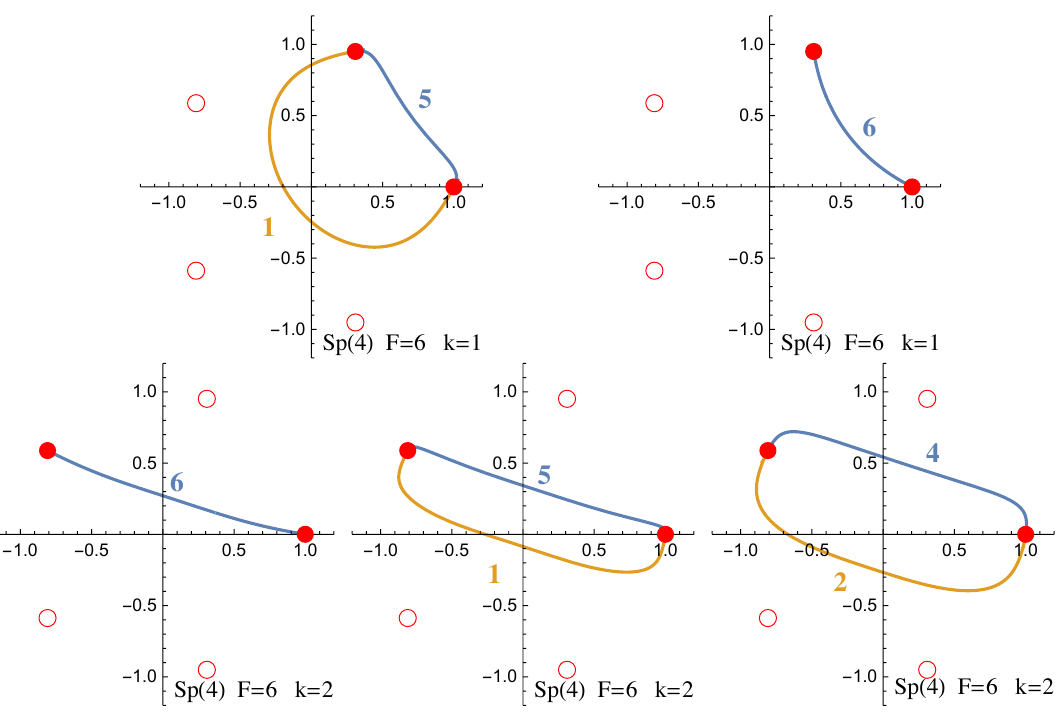
Figure 5 . Examples of domain walls in Sp(4) , F = 6 : on the first row there are the 1-wall solutions, whereas on the second row there are the 2-wall